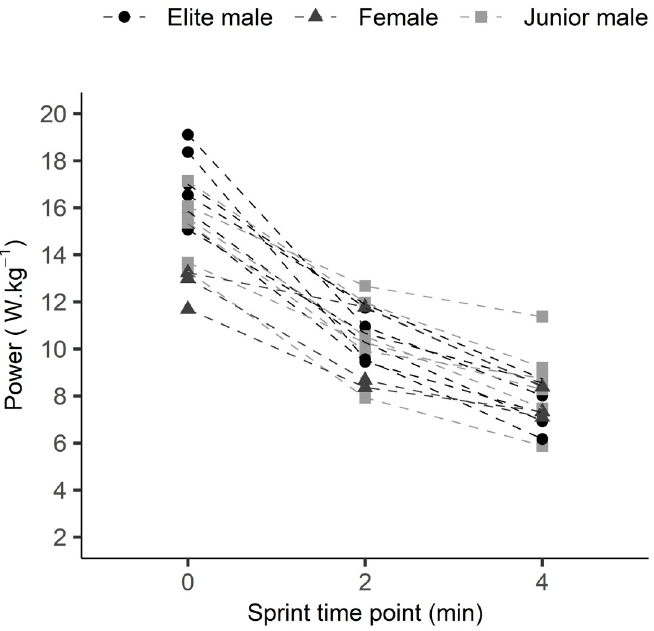
Fig 6. Peak power (relative to body mass) before and after the 2- and 4-min CWR tests for all participants. Irrespective of individual variation, a greater overall functional deficit was observed for the longer test duration. Sprint time point ‘0’ represents the relative peak power in pre-CWR sprints whereas time points ‘2’ and ‘4’ represent the relative peak power in sprints performed after the 2-min and 4-min CWR tests, respectively. Shapes represent the different groups of cyclists: Black dots = elite men, light grey squares = junior (U19) men, dark grey triangles = women.